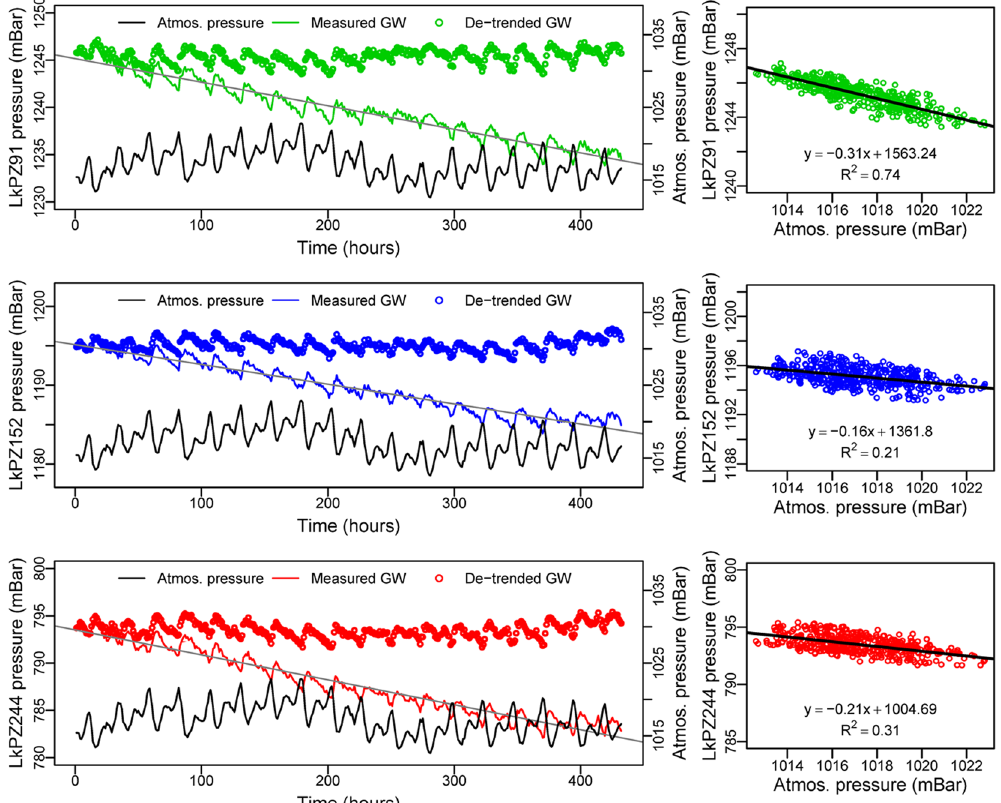
Figure 4. Barometric efficiency, B , determined from the inverse relationship between atmospheric pressure and groundwater pressure. Left: Atmospheric pressure (black line) and measured groundwater (GW) pressure at LkPZ91 (green line), LkPZ152 (blue line) and LkPZ244 (red line) with the linear recession trends (grey lines) and as de-trended groundwater pressure series (open circles, colours as above); time is in hours, from 00.00 hours on 14/1/2014 to 24.00 hours on 31/1/2014. Right: De-trended groundwater pressure at LkPZ91 (green), LkPZ152 (blue) and LkPZ244 (red) versus atmospheric pressure, giving the barometric efficiency, B, as the negative value of the linear regression